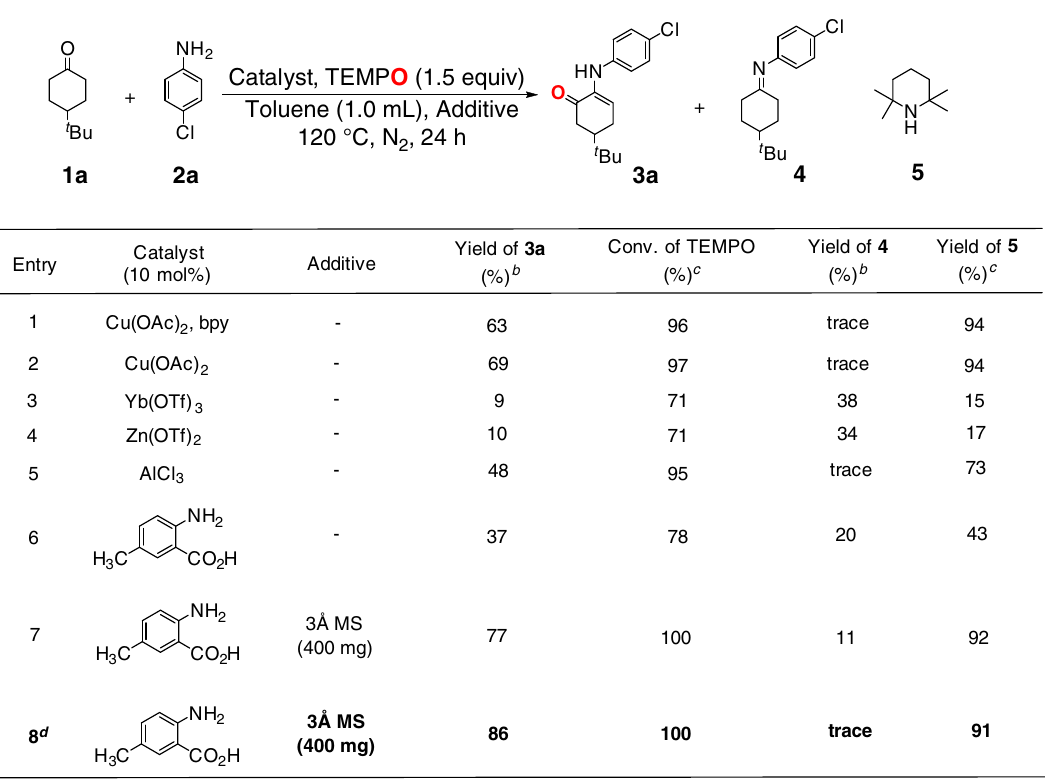
Fig. 2 Optimization of α -amino-enone formation from primary amine a . a Reaction conditions: 1a (0.3 mmol), 2a (0.2 mmol), catalyst (10 mol%), solvent (1.0 mL), N 2 , 120 °C for 24 h. b Yields were determined by GC analysis using dodecane as an internal standard. c Conversion of TEMPO and yield of 5 were based on the amount of TEMPO and determined by GC analysis. d 15 mol% catalyst was